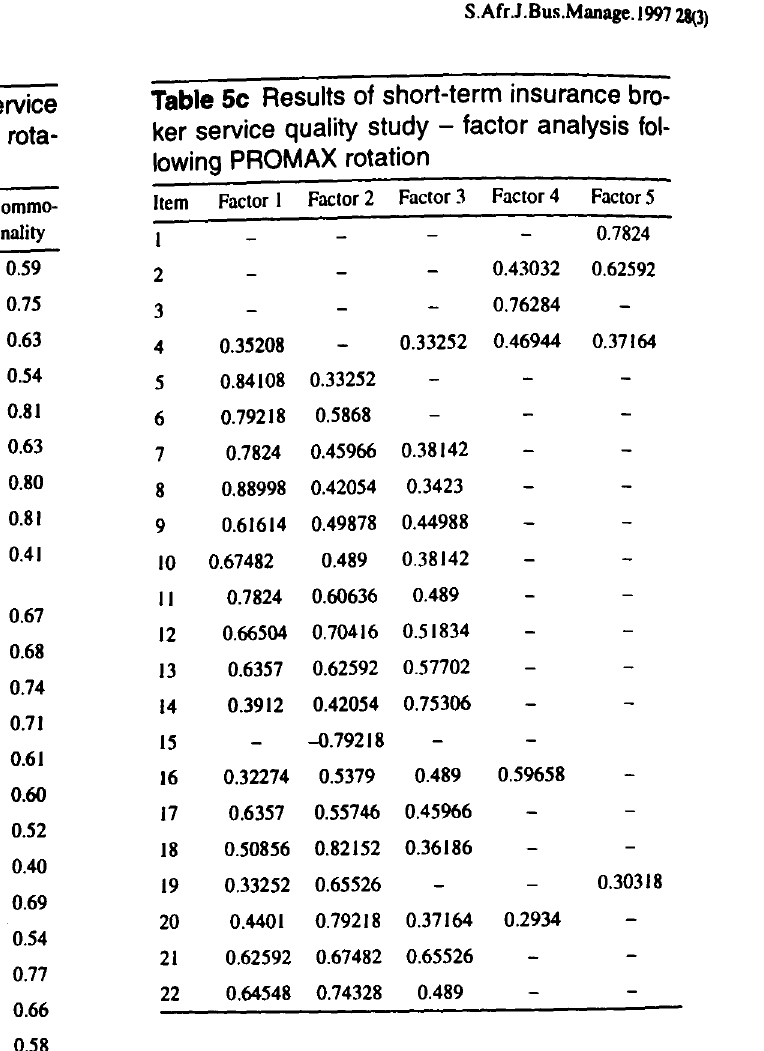
Table Sc Results of short-term insurance bro- ker service quality study - factor analysis